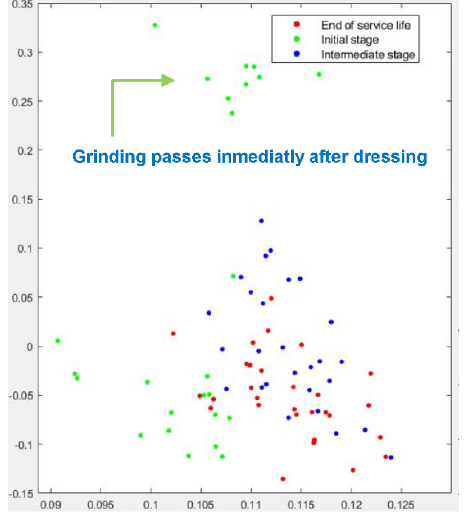
Figure 8. Graphical results of PCA analysis for Test No. 1.